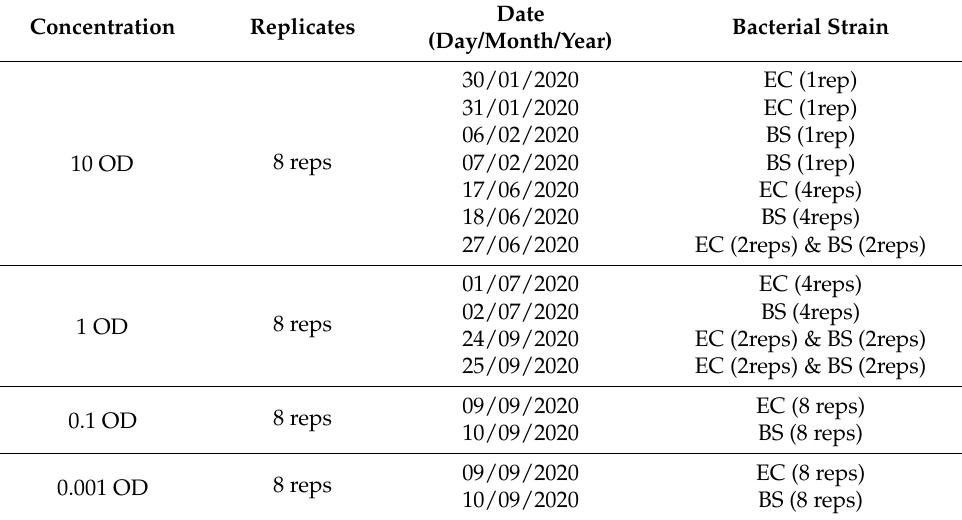
Table 1. Details regarding sample replicate deposited on the stainless steel. Concentration Replicates Bacterial Strain